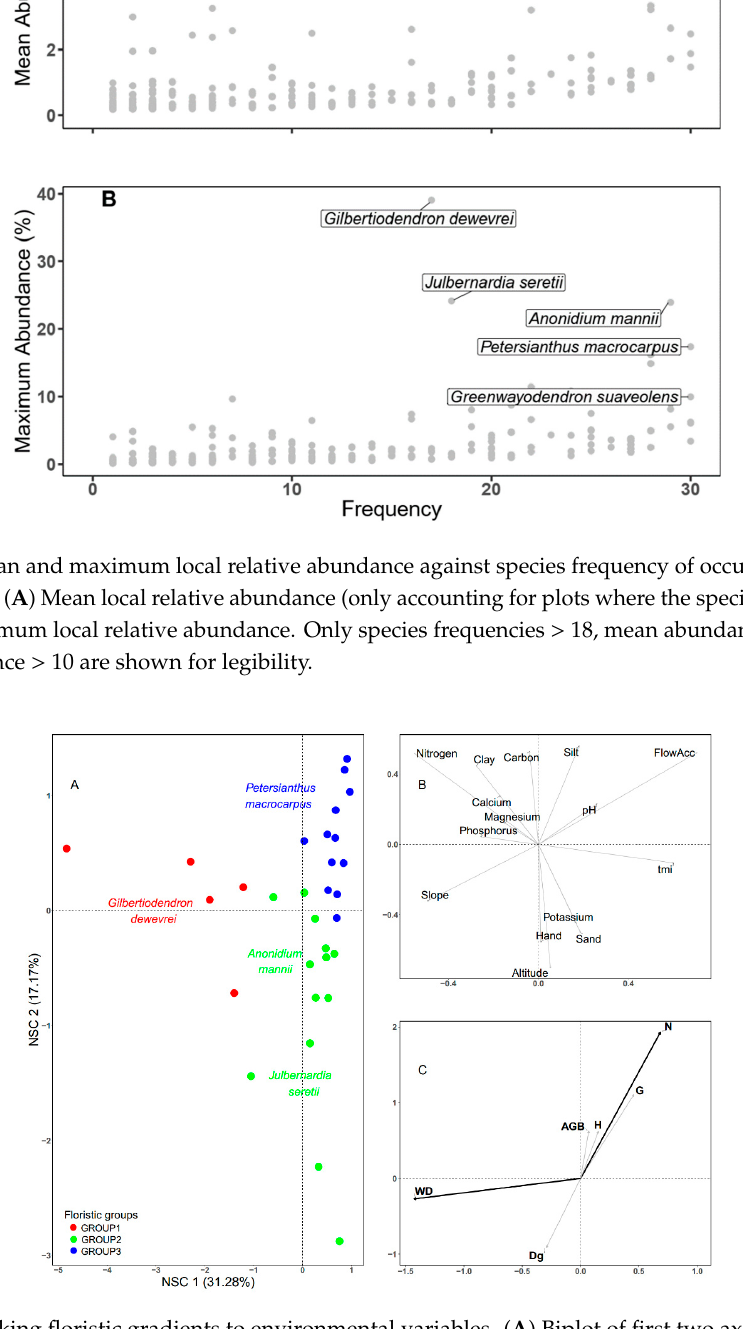
Figure 3. Linking floristic gradients to environmental variables. ( A ) Biplot of first two axes of floristic composition depicted from nonsymmetrical correspondence analysis (NSCA); dots represent 1-ha plots and dot colors represent groups from k -means clustering. ( B ) Projected correlation with soil and topographic variables. ( C ) Projected correlation with forest attributes. Grey arrows represent nonsignificant correlations and bold arrows represent significant correlations after permutation test. All variables are defined in Table 1.